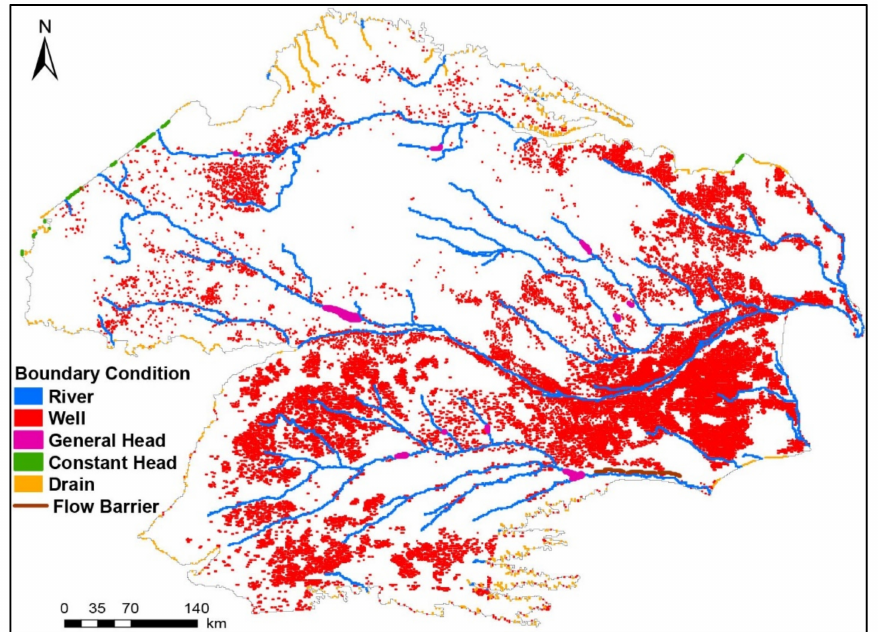
Figure 2. Boundary conditions of the MODFLOW model